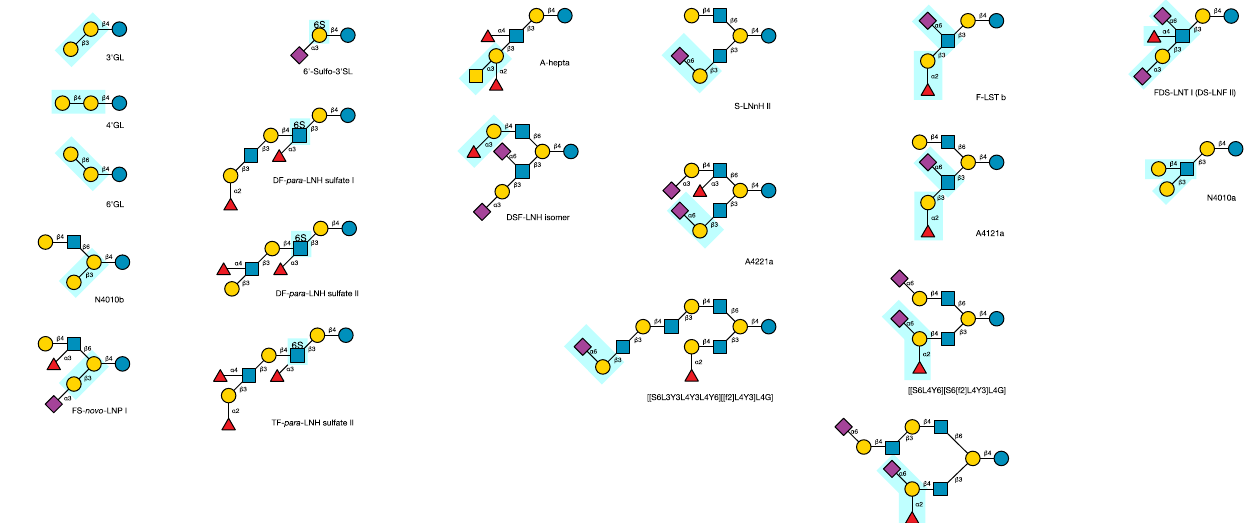
Figure 9. Structures of HMOs that were not predicted by the model. Highlighted motifs (boxed regions) suggest possible additional enzyme activities. See text for